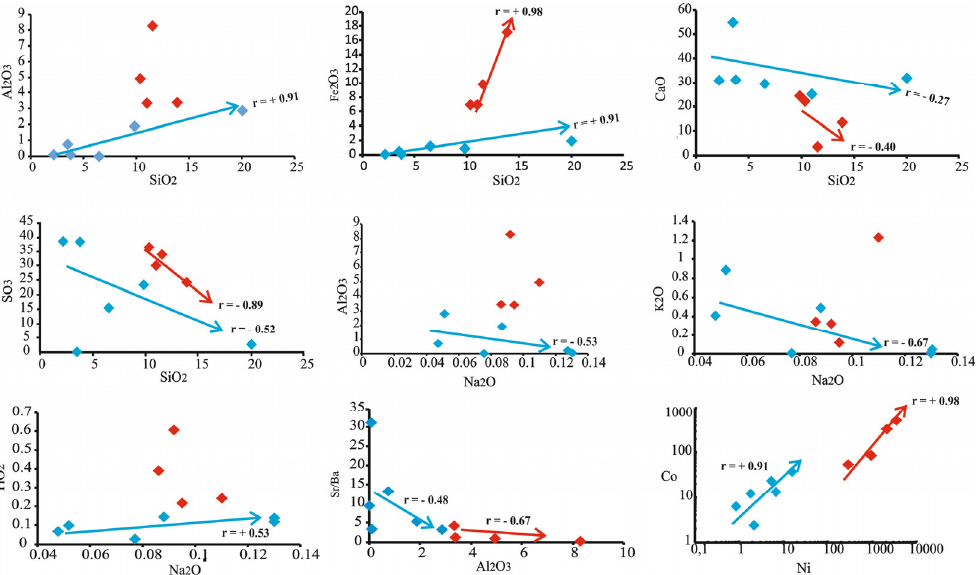
Figure 7. The variation diagrams between major oxides and trace elements of the evaporate rock samples